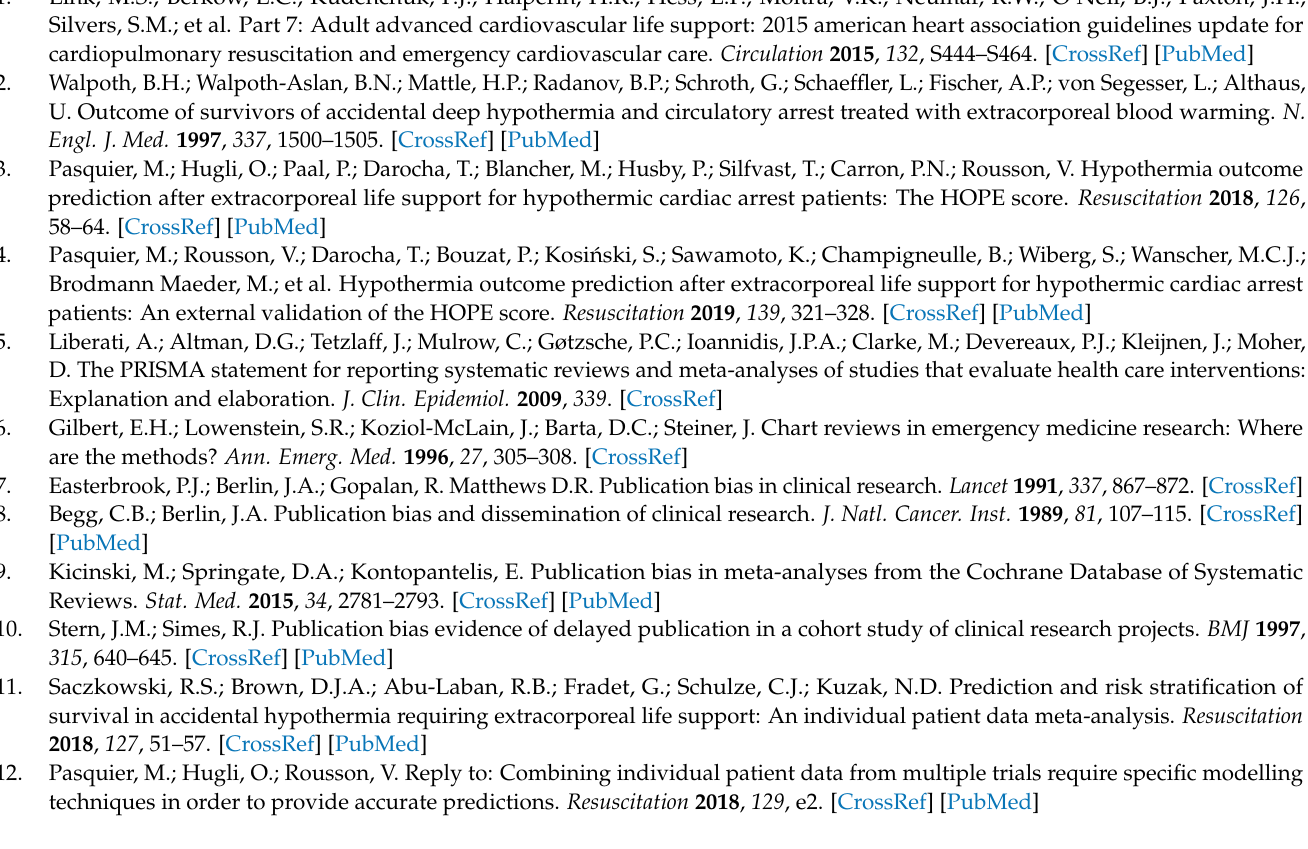
Table S3: Source and characteristics of the 70 selected patients identified through the literature review ( n = 64